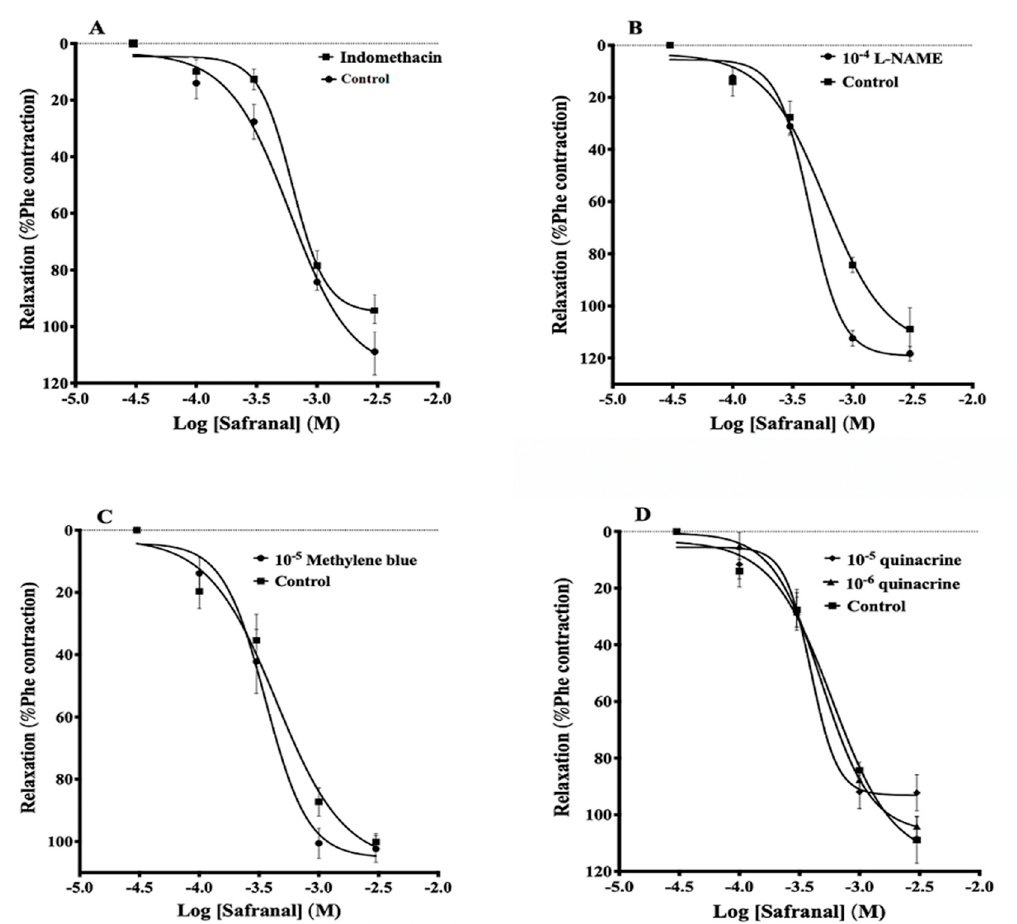
Figure 2. Safranal-induced vasorelaxation in the presence of indomethacin ( A ), L-NAME ( B ), methylene blue ( C ), and quinacrine ( D ). Aortic vessels were precontracted with 5 × 10 − 5 M Phe, then challenged with safranal in the absence or the presence of the inhibitors. Values are expressed as means ± SEM. n = 9 for ( A , B ); n = 7 for ( C , D ).